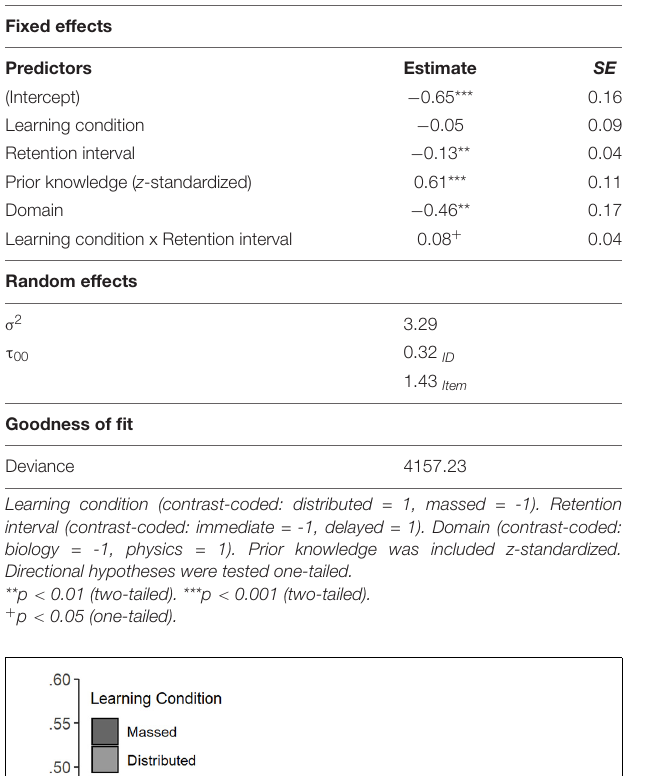
TABLE 4 | Parameter estimates and significance tests for the generalized mixed model for learning outcomes in experiment 2.